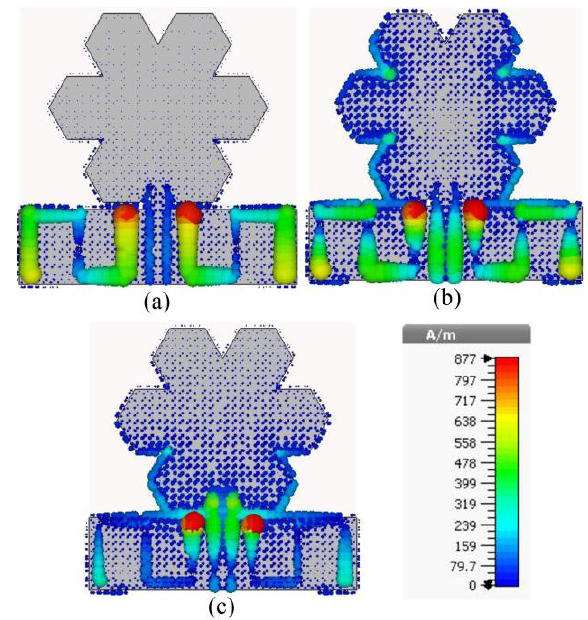
Figure 8 : Simulated surface current distribution observed from the ground planeside: (a) 2.4, (b) 3.6 and (c) 5.8GHz.